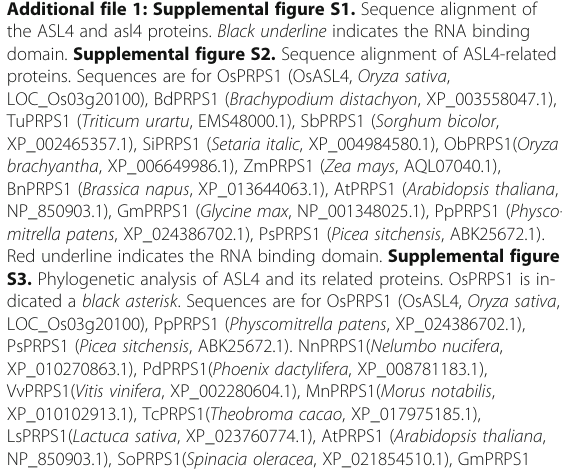
Additional file 1: Supplemental figure S1. Sequence alignment of the ASL4 and asl4 proteins. Black underline indicates the RNA binding domain. Supplemental figure S2. Sequence alignment of ASL4-related proteins. Sequences are for OsPRPS1 (OsASL4, Oryza sativa , LOC_Os03g20100), BdPRPS1 ( Brachypodium distachyon , XP_003558047.1), TuPRPS1 ( Triticum urartu , EMS48000.1), SbPRPS1 ( Sorghum bicolor ,